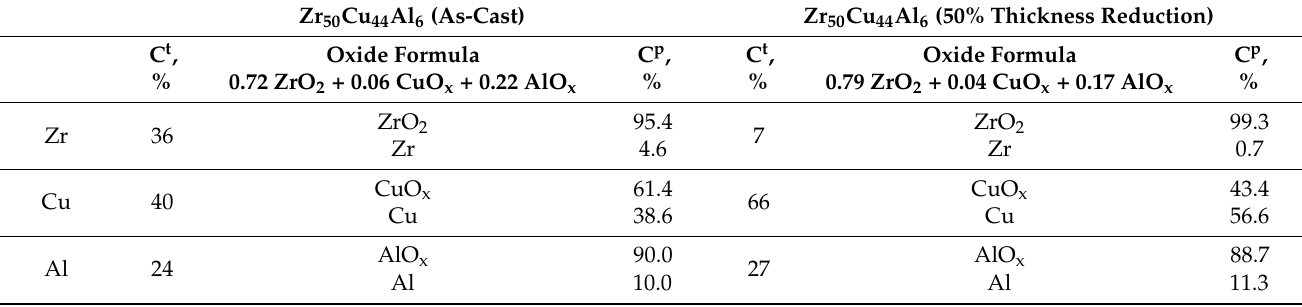
Table 2. Chemical composition of the native oxide layer on the surface of A1 ribbons, including R0 and R50 in at% measured by XPS. Ct indicates the total element content of the native oxide layer; Cp denotes the partial content of different compounds.